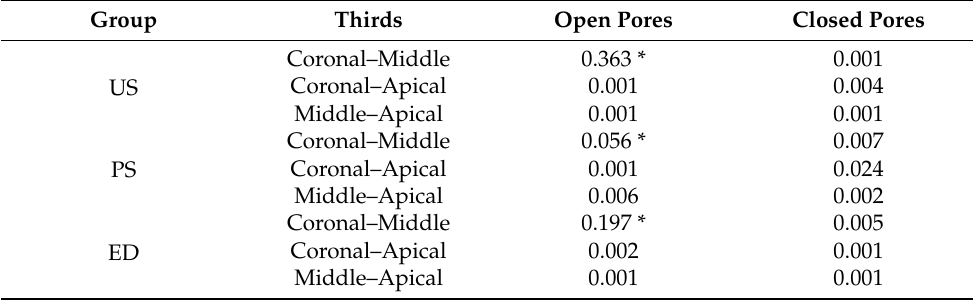
Table 2. p -Values from pairwise comparisons of the root canal thirds in the respective group. Group Open